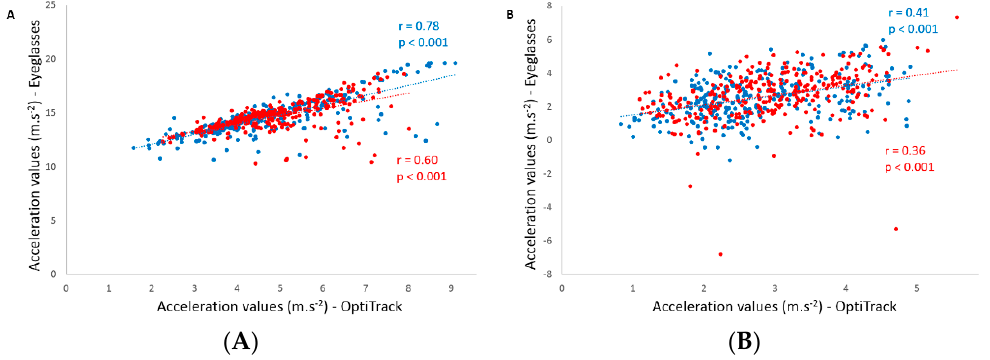
Figure 3. Pearson’s correlation of the acceleration values measured for the vertical (panel A ) and anteroposterior (panel B ) axes during comfort speed without the cervical collar for the first (blue dots) and the second (red dots) session.